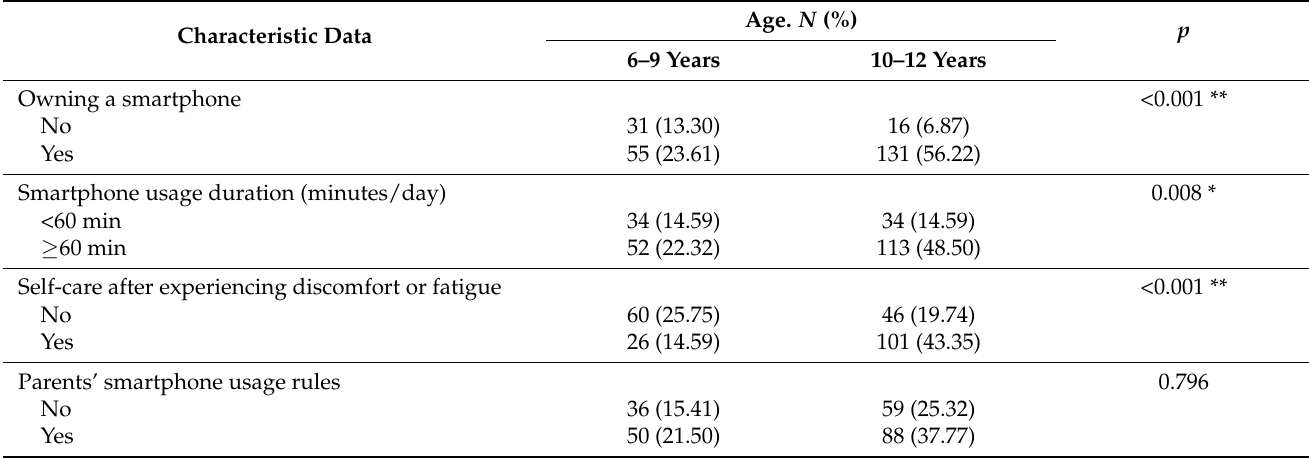
Table 3. Relationships between factors and